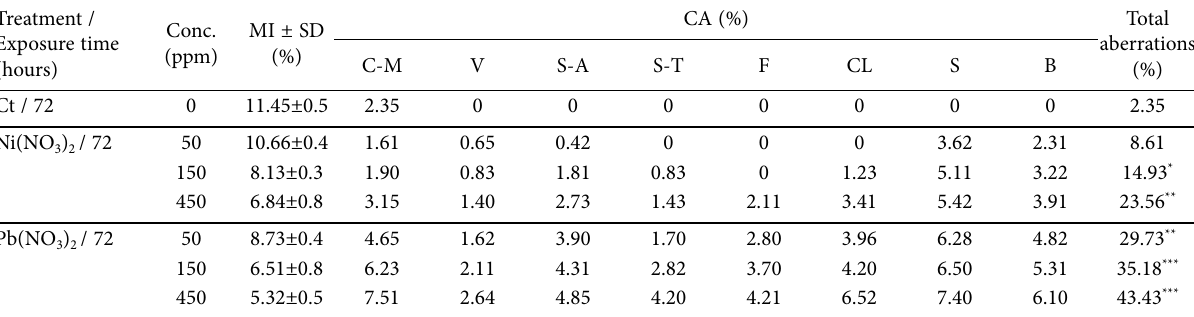
Table 1. Mitotic index, type and percentage of mitotic aberrations induced by some heavy metals on the meristematic roots to A. sativum. Treatment / Exposure time